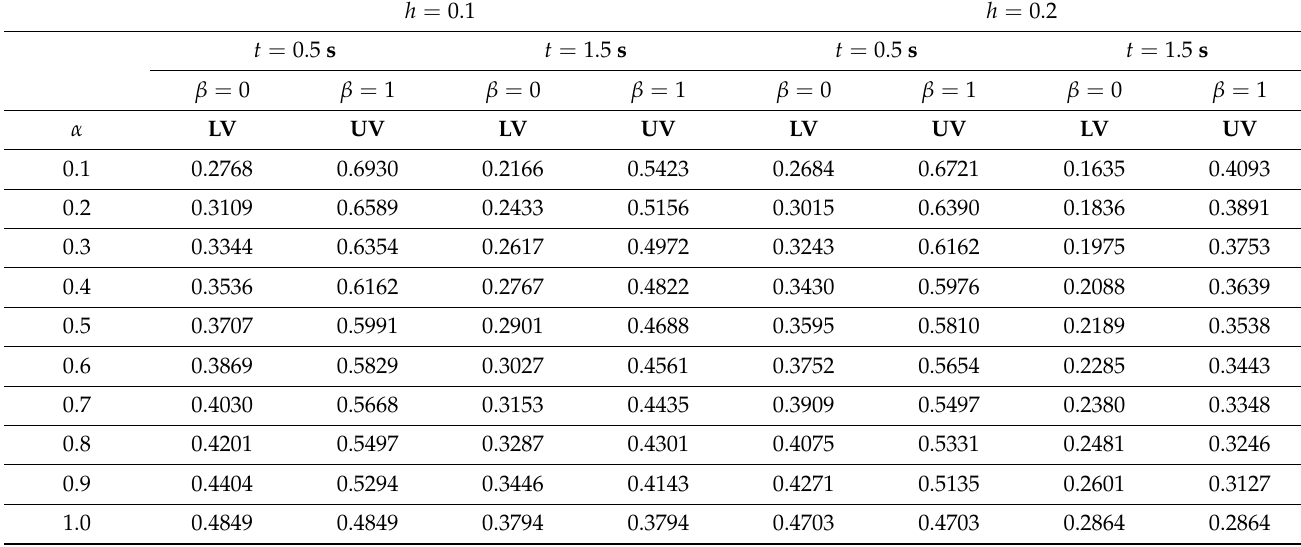
Table 8. Fuzzy solution of η for h = 0.1 and h =